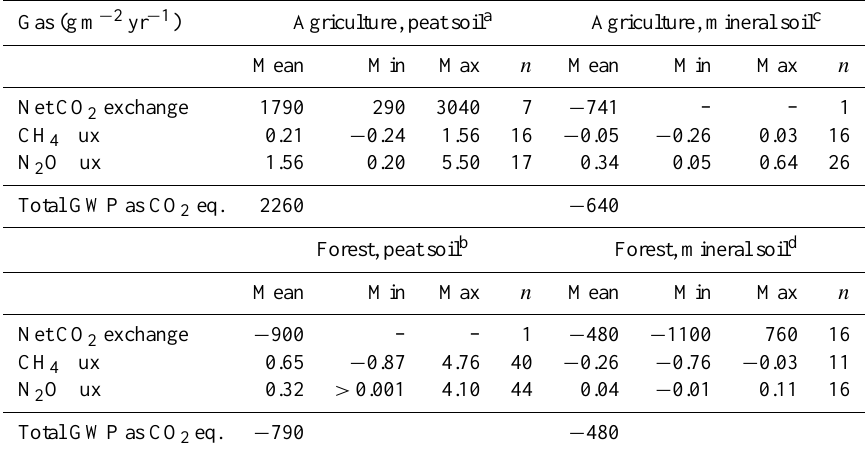
a Data from Table 3. excluding fallow and abandoned soils. b Data from Table 2. excluding clear cut and restored sites. c Data from Ambus (1998); Ambus et al. ( 2001); Chatskikh and Olesen, (2007); Flechard et al. (2007); Kanerva et al. (2007); Kasimir and Klemedtsson (unpubl.); Maljanen et al. (2007b), Virkajärvi et al. (2010); Perälä et al.